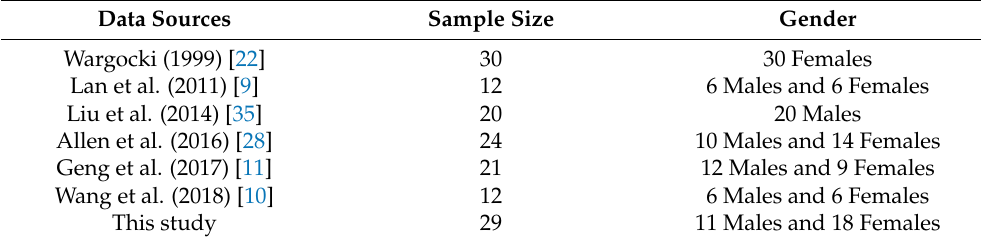
Table 3. Comparison of sample sizes in different studies.